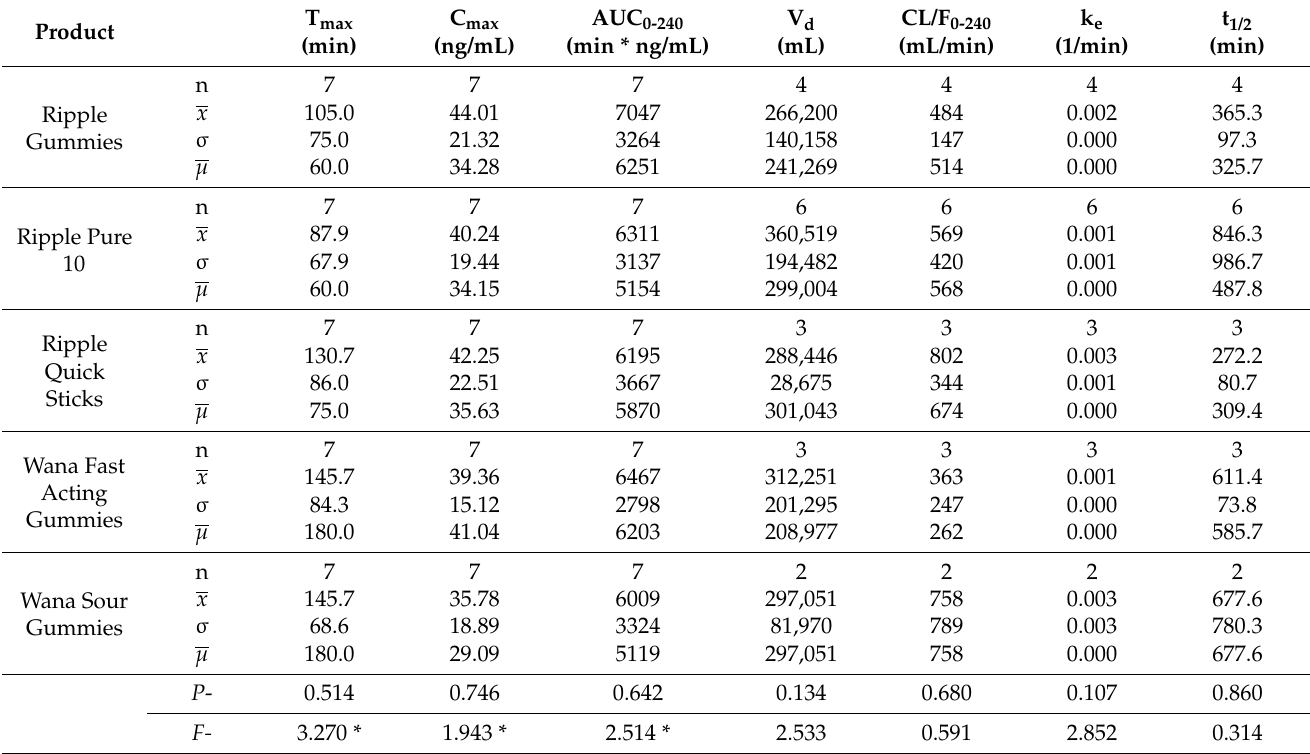
Table 5. Pharmacokinetic parameters for THC-COOH.